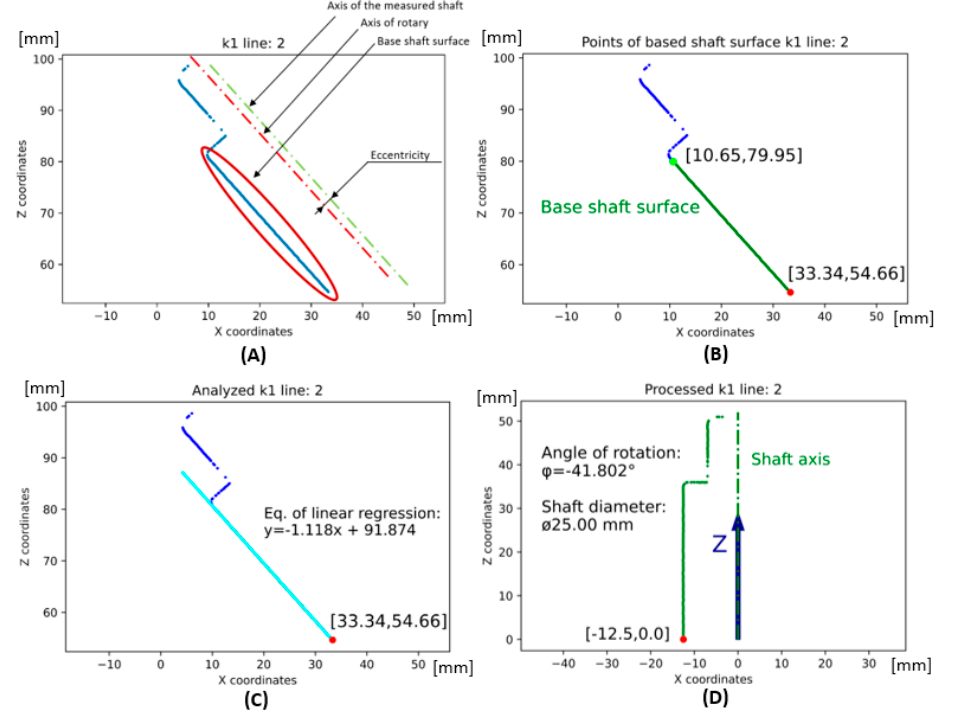
Figure 6. ( A ) Line scan XZ—axis in S-reference system, ( B ) definition base shaft surface, ( C ) linear regression according to base shaft surface, ( D ) transformation of point cloud into C-reference system.